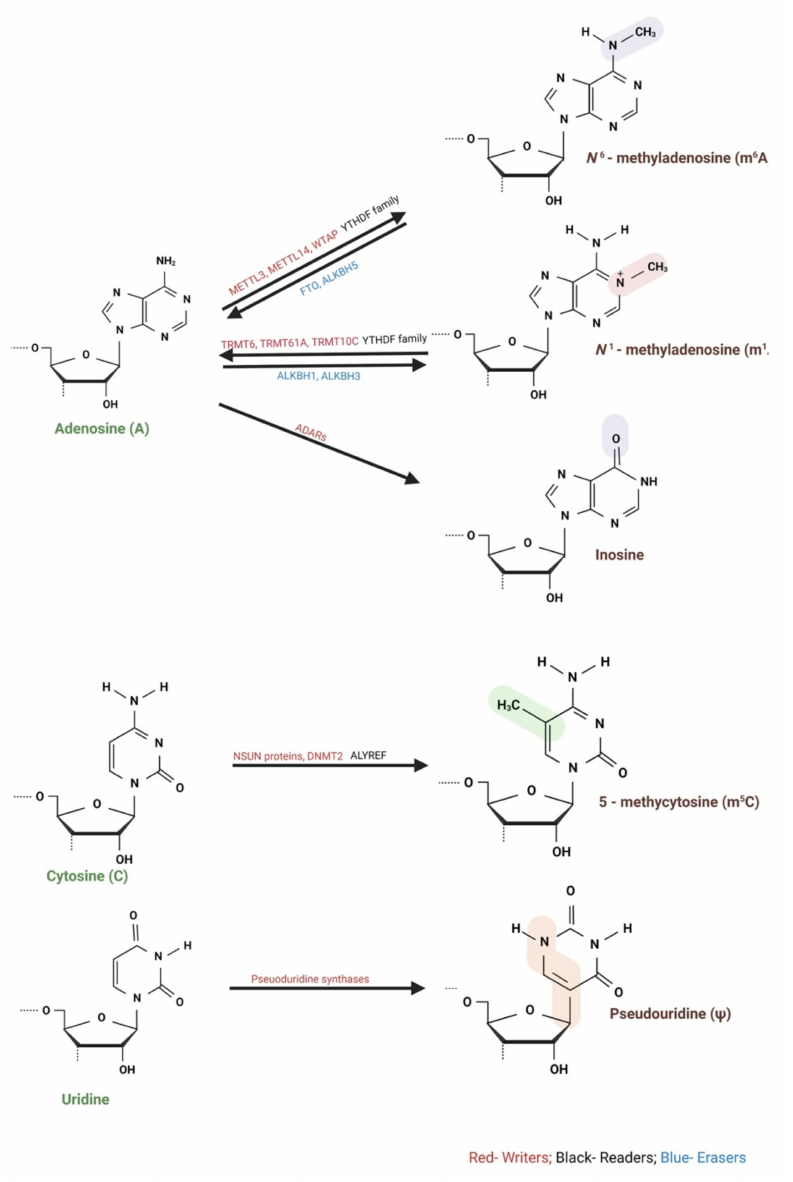
Figure 1. Schematic representations of RNA modifications. ADAR, adenosine (A) to inosine (I) RNA editing; AlyREF, Aly/REF export factor; ALKBH proteins, alkB homolog; DNMT2, DNA methyltransferase-like 2; FTO, fat mass and obesity-associated protein; m 1 A, N1-methyladenosine; m 6 A, N6-methyladenosine; m 5 C, 5-methylcytosine; METTL, methyltransferase-like; NSUN, NOP2/Sun domain family members; PUS, pseudouridine synthase; RNMT, RNA guanine-7 methyl- transferase; RPUSD, RNA pseudouridine synthase domain-containing protein; TRM6, transfer RNA methyltransferase non-catalytic subunit 6; TRM61, transfer RNA methyltransferase catalytic subunit 61; TRMT10, transfer RNA methyltransferase 10; YTHDC, YTH domain-containing; YTHDF, YTH domain-containing family. Created with BioRender.com accessed on 31 March